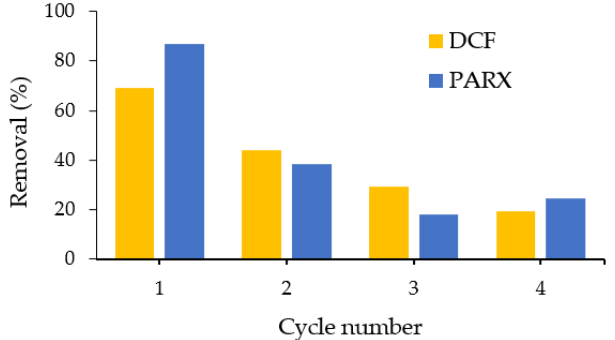
Figure 10. Influence of the regeneration cycle on the removal efficiency of DCF and PARX with ACK